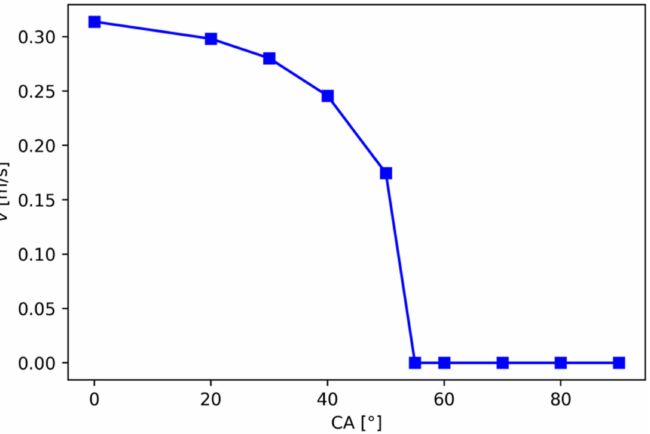
Figure 12. v as function of CA for homogenous coating simulated by